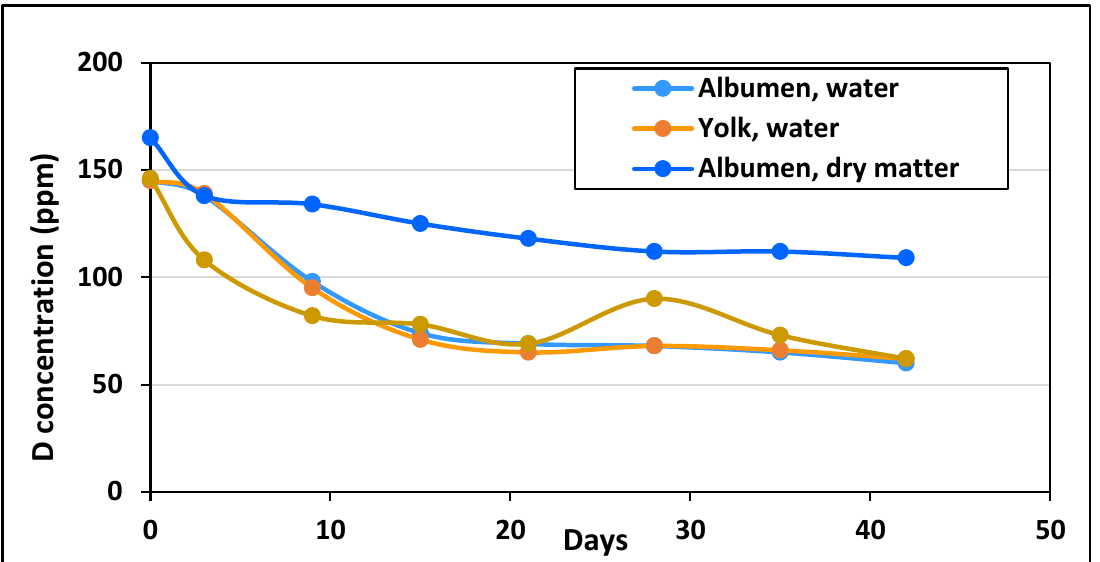
Figure 1. Changes of the D concentration in the water and the organic compounds of eggs after replacement of normal drinking water with 25 ppm DDW (the data represent the average of measurements on two independent samples.).